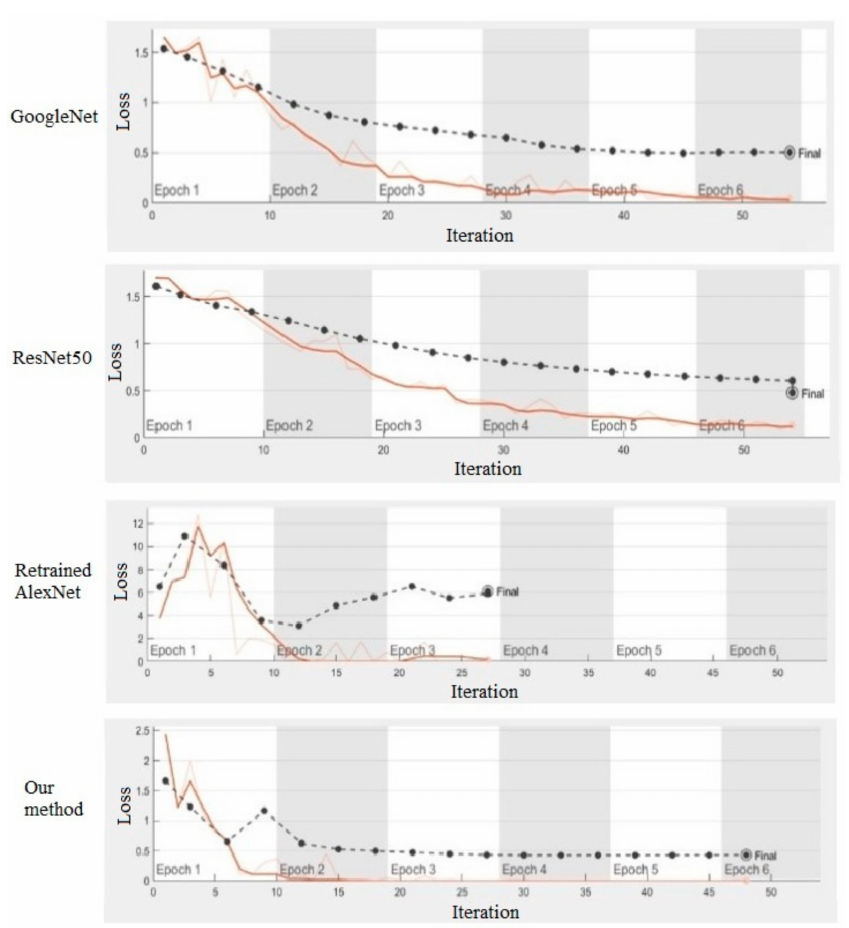
Figure 13. Loss curve of different